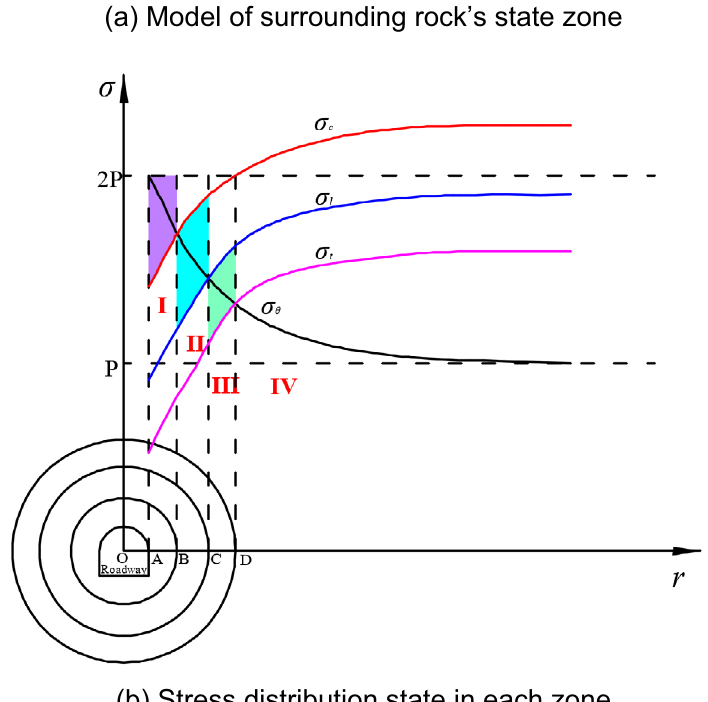
Figure 3. Classification model and stress distribution of surrounding rock’s state zone under creep perturbation (where I: Fractured zone; II: Perturbation sensitive zone (stable creeping zone); III: Perturbation insensitive zone (attenuated creeping zone); IV: Elastic zone; P : Original stress level; σ θ :Tangential concentrated stress on surrounding rock; σ c : Ultimate strength of surrounding rock; σ l : Anti-perturbation strength of surrounding rock; σ t : Threshold strength of surrounding rock when creep